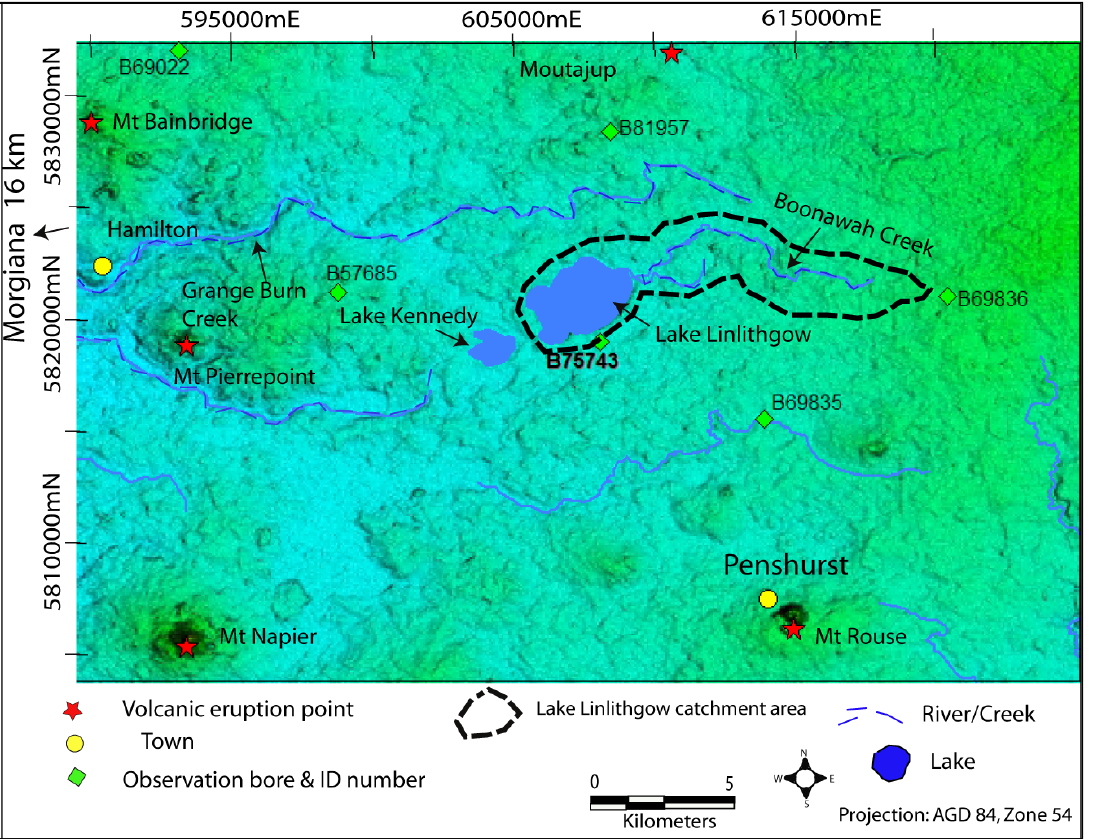
Figure 1. Digital elevation model showing the relative elevation of the terrain surrounding Lake